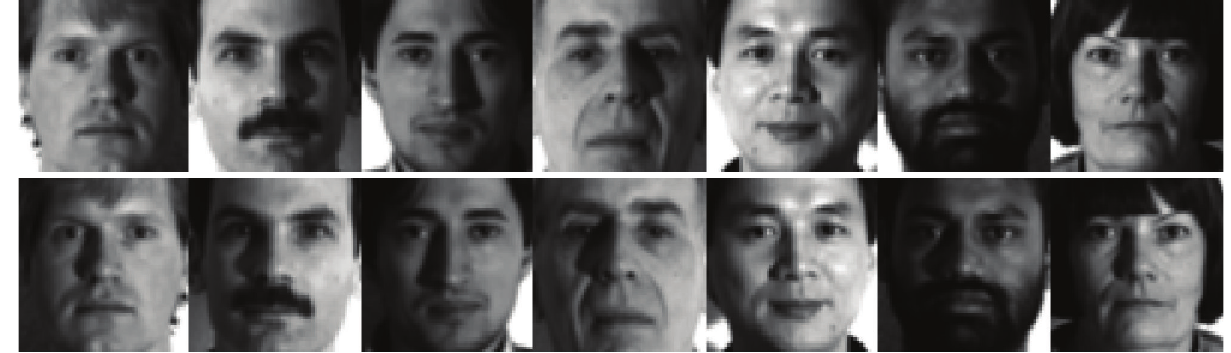
Figure 3: Some original training samples from the Yale database and the mirror faces generated from the original training samples. The first row shows the original training samples. The second row shows the mirror faces generated from the original training samples.